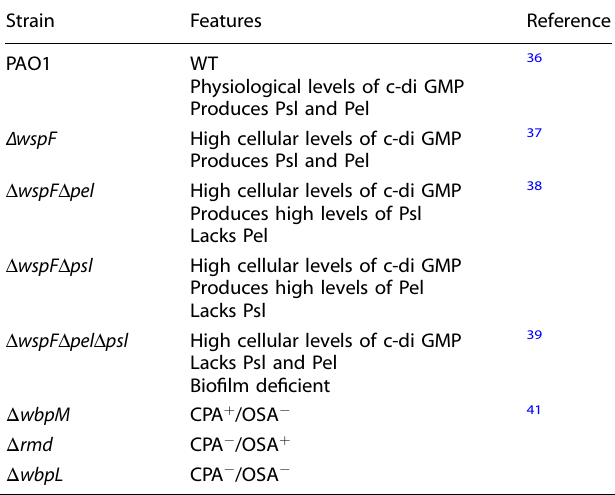
Table 1. Strains used in this